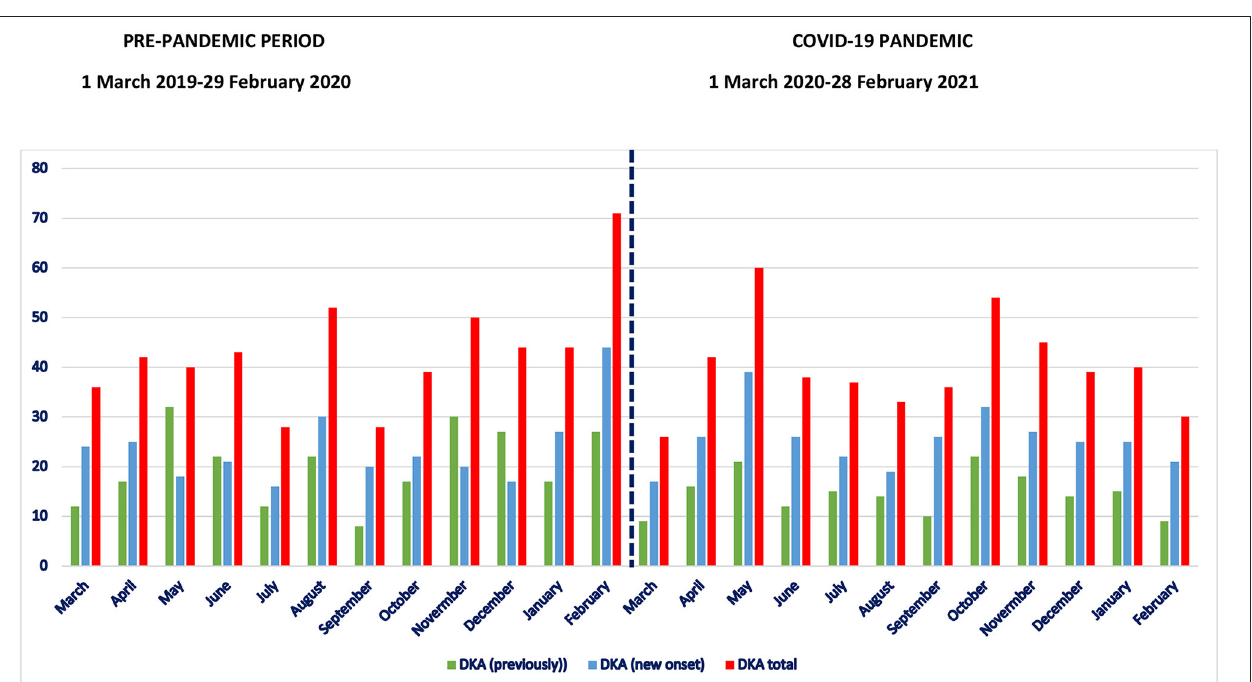
no difference for age of onset of diabetes between pre-pandemic and pandemic period ( p > 0.05). The body mass index (BMI)